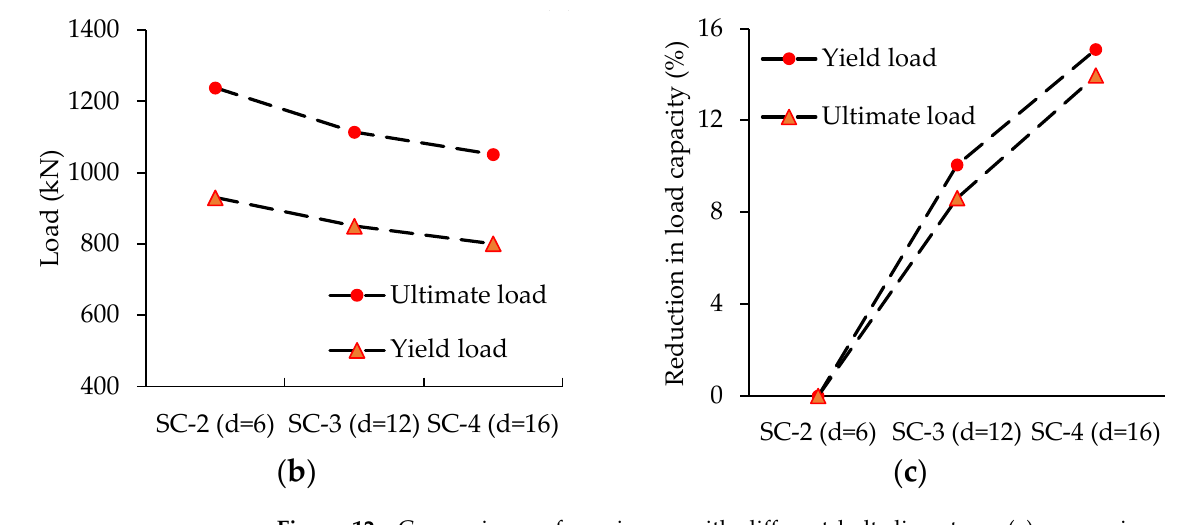
Figure 12. Comparisons of specimens with different bolt diameters: ( a ) comparisons of load-displacement curves with various bolt diameters; ( b ) yield load and ultimate load with different bolt diameters; and ( c ) percentage variation of load capacity with various bolt diameters.